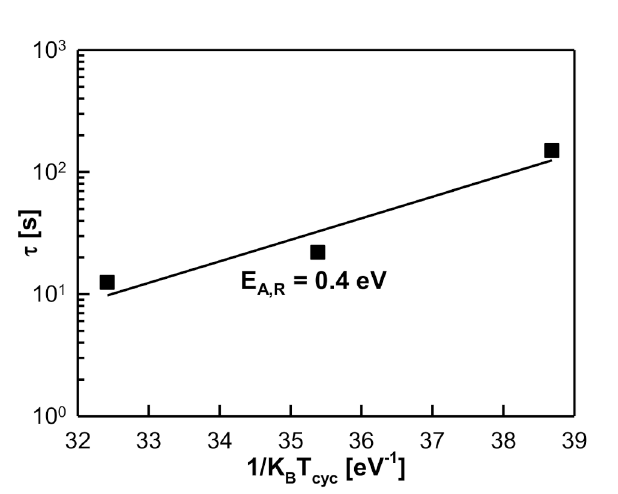
Figure 17. E A , R obtained using Equation (7) for different values of T cyc . Reprinted from